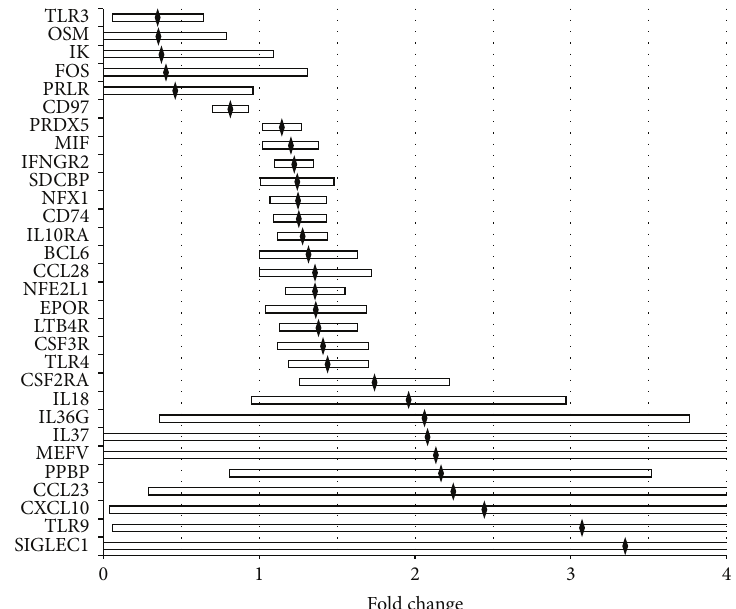
Figure 1: Genes identified with altered expression in adipose tissues treated with preeclampsia sera. Thirty genes showed alteration at least 2-fold or statistical significance ( 𝑃 < 0.05 , unpaired 𝑡 -test). Black diamond shows mean and open bars show 95% CI of respective